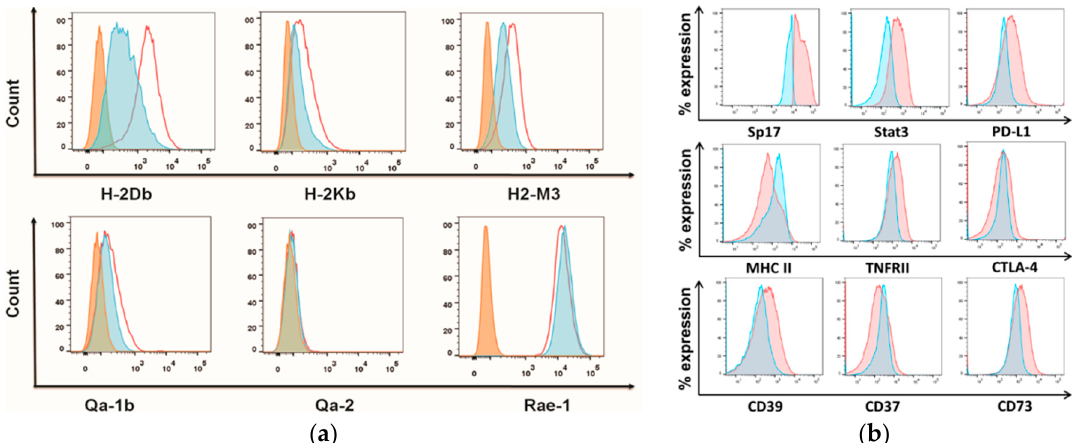
Figure 3. Sp17 expression modulates major histocompatibility class (MHC) expression and correlates with immunosuppressive molecules in ID8 cells. ( a ) Classical and non-classical MHC I molecule expression (H2-Db, H2-Kb, H2-M3, Qa-1b, Qa-2, and ribonucleic acid export 1 (rae-1)) in Sp17 + and Sp17 − ID8 cells. Data is shown as histograms of each marker relative expression on Sp17 + (red unshaded) and Sp17 − (blue) ID8 cells, as well as isotype control (orange); ( b ) Immunosuppressive molecules expressions (PD-L1, MHCII, CD39, CD37, CD73, cytotoxic T lymphocyte associated antigen-4 (CTLA-4), tumor necrosis factor receptor II (TNFRII), and STAT3) on gated Sp17 + and Sp17 − ID8 cells. The Sp17 + and Sp17 − ID8 cells (for Figure 3a) or un-fractionated ID8 cells (for Figure 3b) were stained with specific antibodies for each immune marker assessed here and analyzed by flow cytometry (see Materials and Methods). Data is shown as histograms for each marker-relative expression in Sp17 + (red) and Sp17 − (blue) ID8 cells, as well as isotype control (orange). The X -axis shows the fluorescence intensity, and Y -axis shows count ( a ) or % expression normalized to mode (as a percent expression relative to each population) ( b ). Results are representative of three independent experiments.